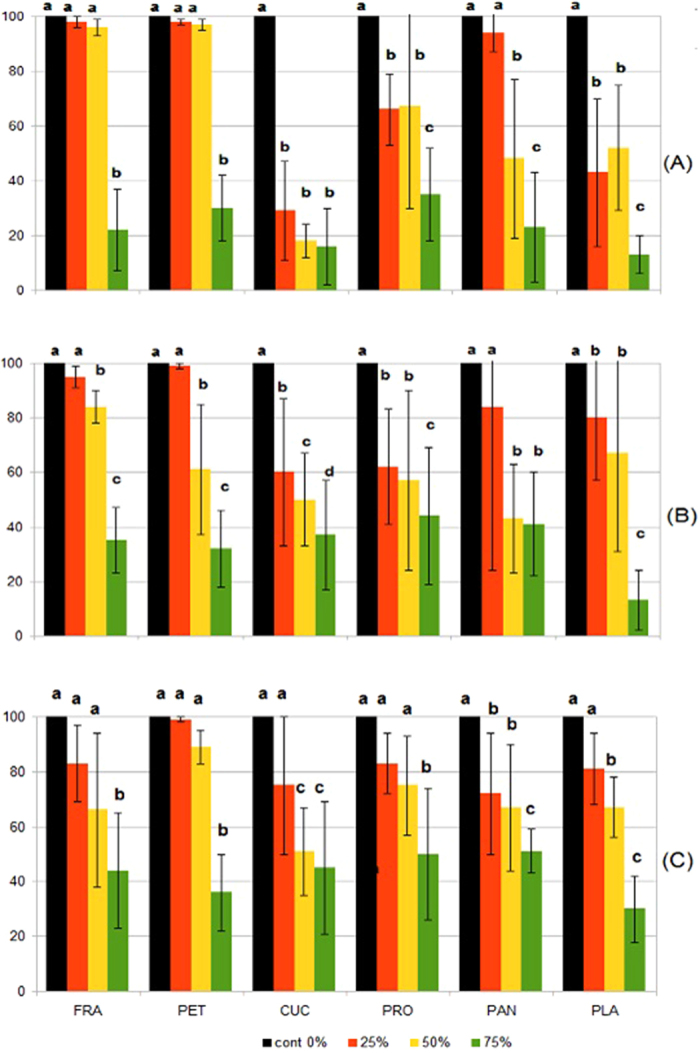
Root and shoot dry mass (A,B) and root length (C) of 90-day old seedlings of six Hakea species with nil or partial removal of cotyledons. Measurements were converted to % using values of the controls as the basis (100%) to facilitate comparisons between treatments. Different letters above bars indicate a significant difference between treatments at P < 0.05. Treatment: cont 0%: control with 0% cotyledon removal; 25%: 25% cotyledon removal, etc. Plant species: FRA, H. francisiana; PET, H. petiolaris; CUC, H. cucullata; PRO, H. prostrata; PAN, H. pandanicarp; and PLA, H. platysperma.